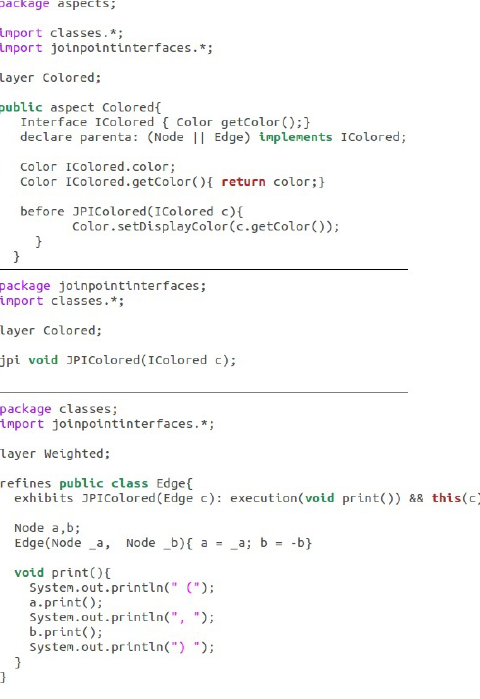
Figure 10: JPI-FM code for the graph example